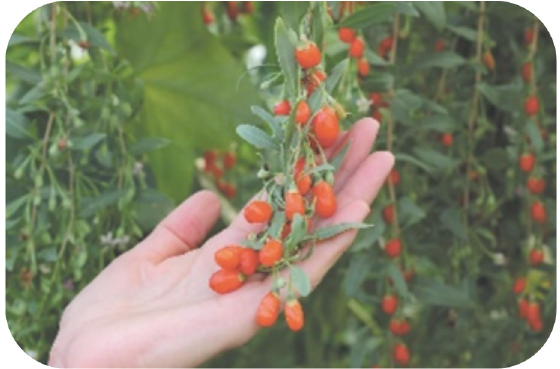
Figure 1. L. barbarum L. berries [29].